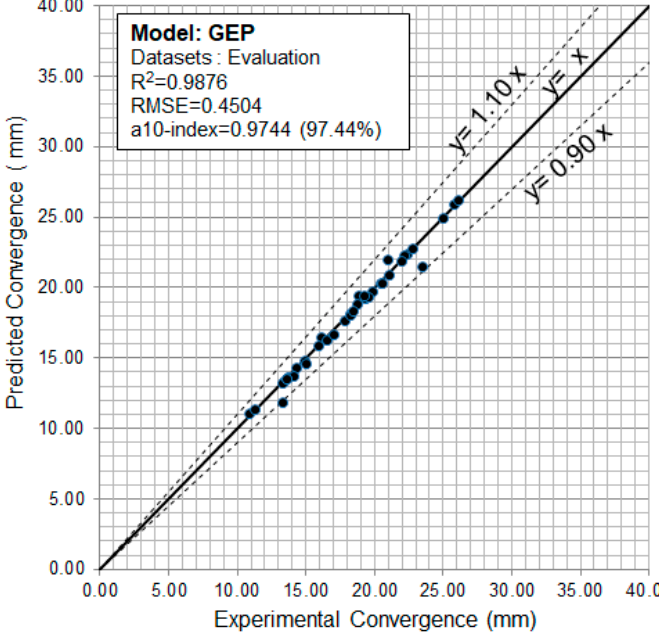
Figure 17. Scatter plot of measured and predicted convergence for validation datasets.